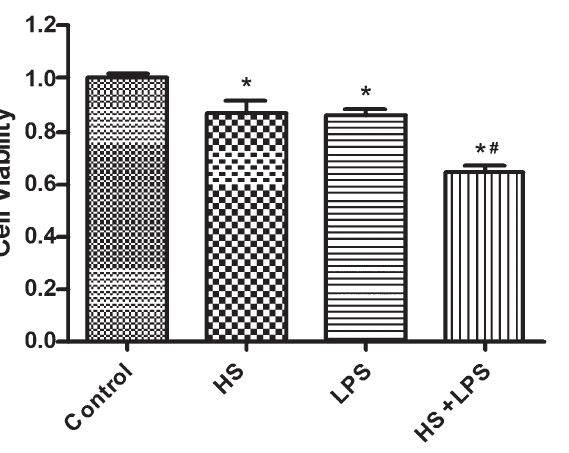
Figure 1. Effects of heat stress (HS) and lipopolysaccharide (LPS) on the cell viability of IEC-6 cells. Data are reported as means±SD, n=6. *P , 0.05 vs control, and # P , 0.05 vs HS or LPS (one-way ANOVA).